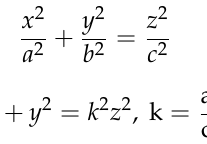
(3) Figure 4. Ellipse seal cone in TOBV and circular seal cone in QOBV.